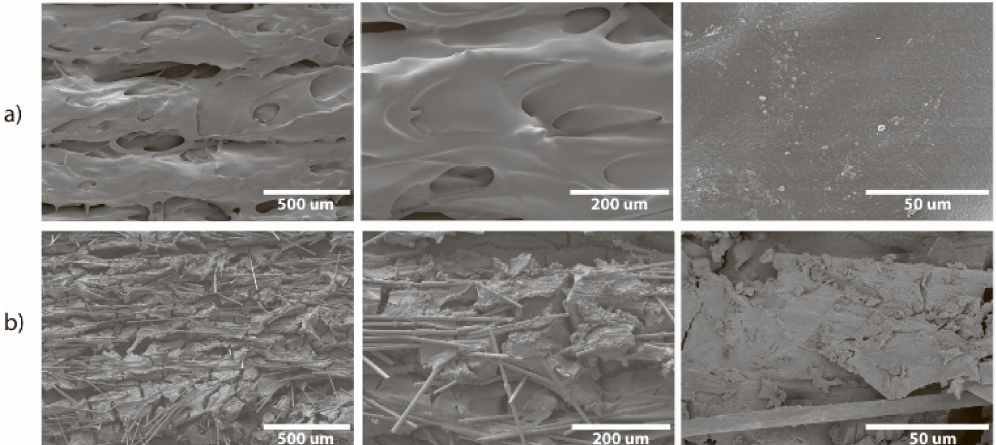
Figure 12. SEM images of the CF-nylon reactor surface at different magnifications: ( a ) before the reaction and ( b ) after 7 cycles of vinyl derivative synthesis (total reaction time is 11 h at 130 ◦